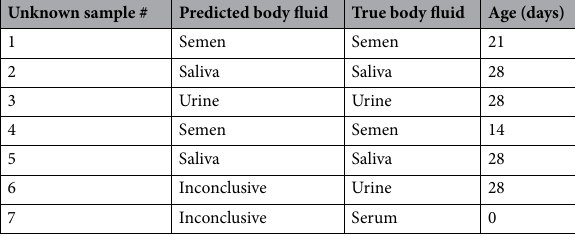
Table 1. Outcome identification unknowns using